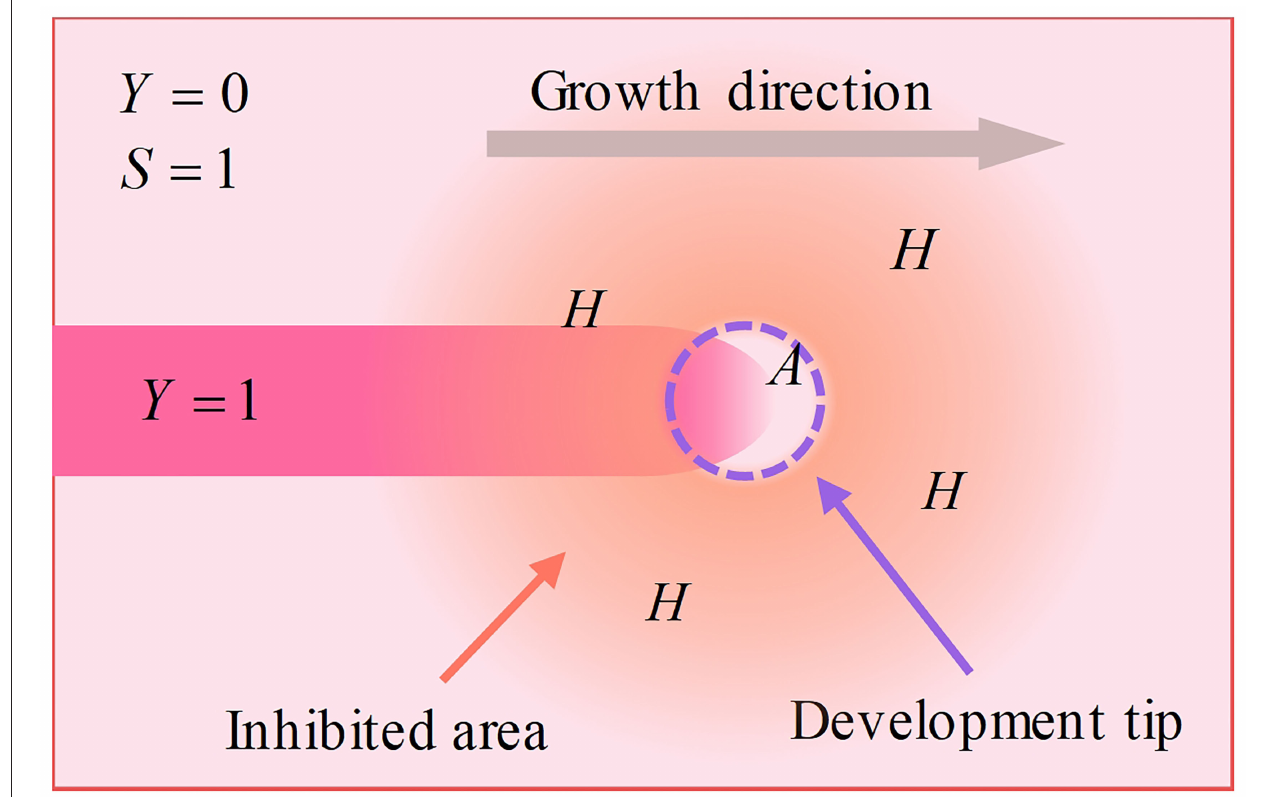
FIGURE 1 | Schematic of the development process. The neuron expresses activators and inhibitors. Activators gather at the tip, while inhibitors diffuse into the surrounding area due to a higher diffusion rate, making only the tip develops. This mechanism makes dendritic spines grow in a certain direction instead of exhibiting isotropous